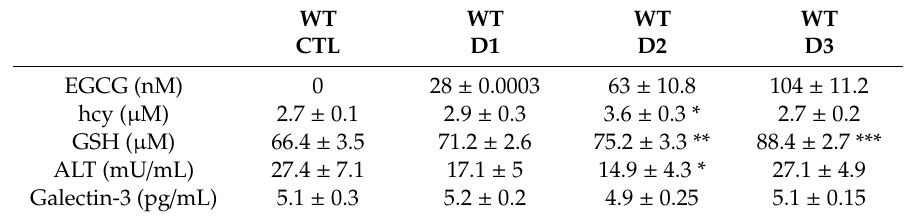
Table 5. Plasma EGCG, hcy, GSH, ALT and Galectin-3 levels in WT mice that have received an oral gavage of low (D1), intermediate (D2) or high (D3) doses of FontUp ® during two days. WT WT CTL